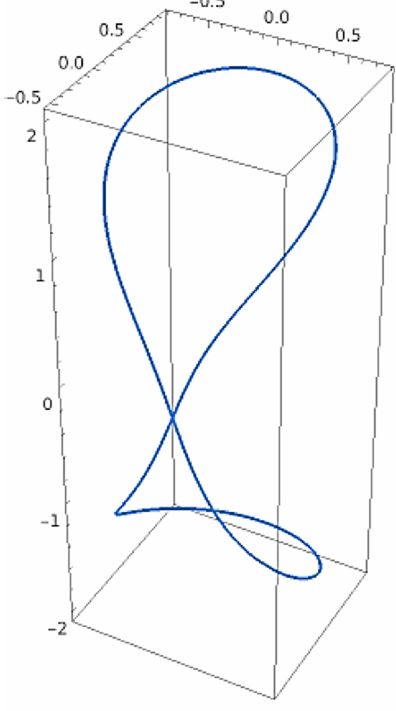
Figure 3. The slant helix